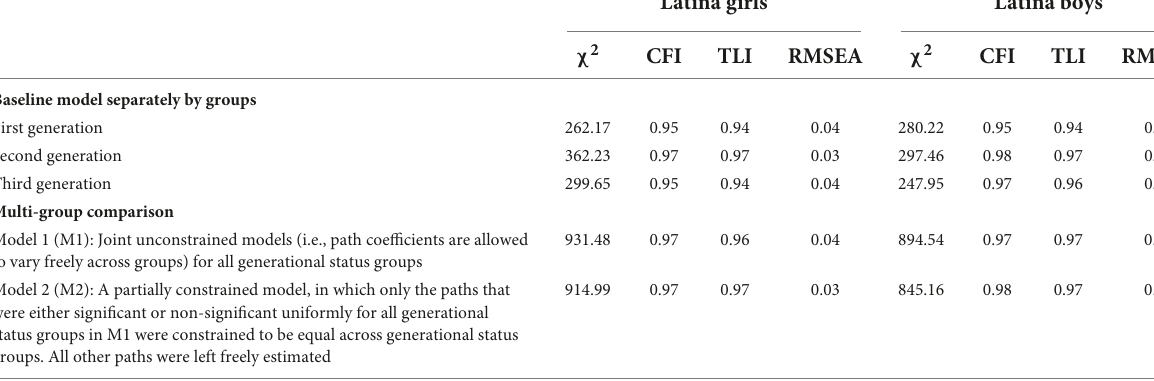
TABLE 3 Structural equation modeling fit statistics for baseline and multi-group comparison